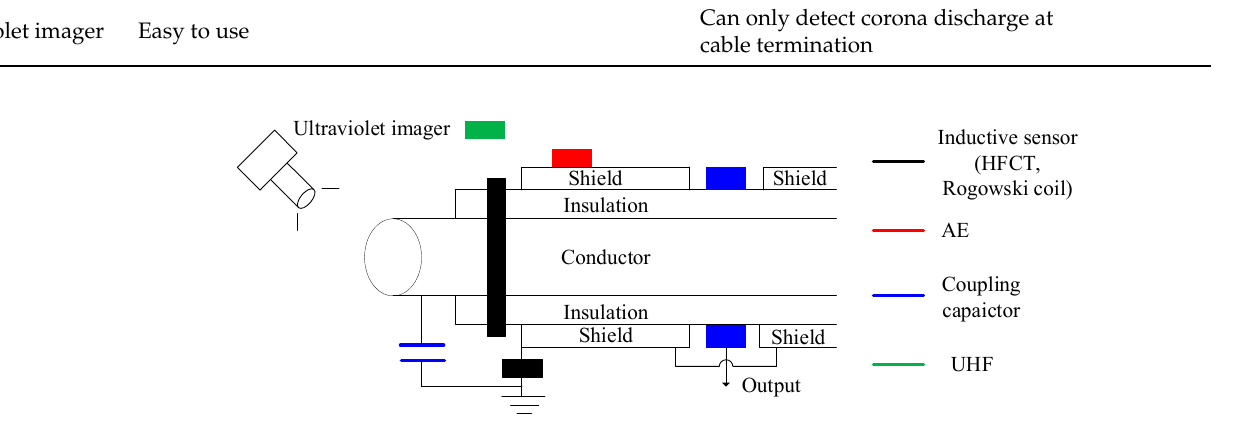
Figure 8. Illustration of sensor locations.